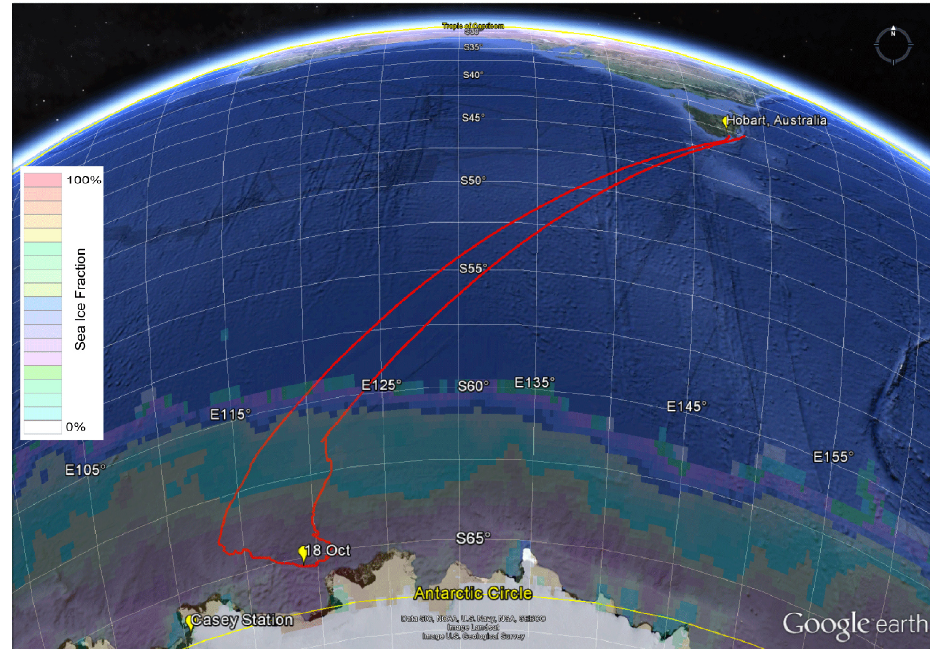
Figure 1. Ship track (red) relative to the departing port (Hobart, Australia) and the Antarctic continent. Sea ice concentration is shown in colours around the continent and is derived from Extended Reconstructed Sea Surface Temperature (ERSST) Version 3b, October 2012 mean. Imagery: Google